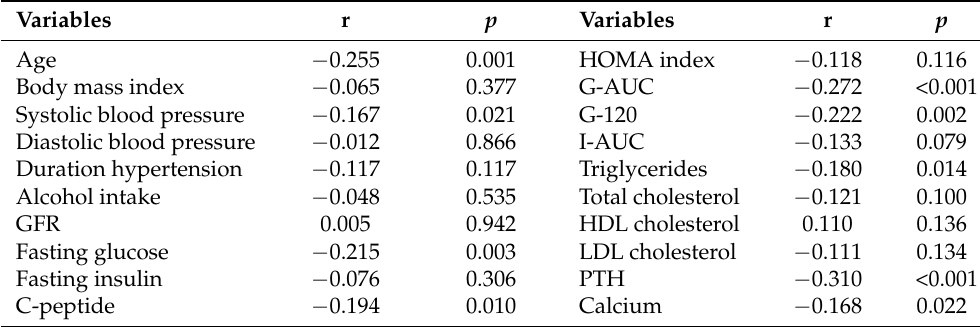
Figure 1. Bar graph showing the prevalence of vitamin D status in hypertensive patients with normal glucose tolerance (NGT) or impaired glucose tolerance (IGT). In nondiabetic hypertensive patients, prevalence of serum 25(OH)D deficiency/insufficiency was significantly higher in patients with impaired than normal glucose tolerance. Table 3. Relationships between log 25(OH)D levels and other study variables.